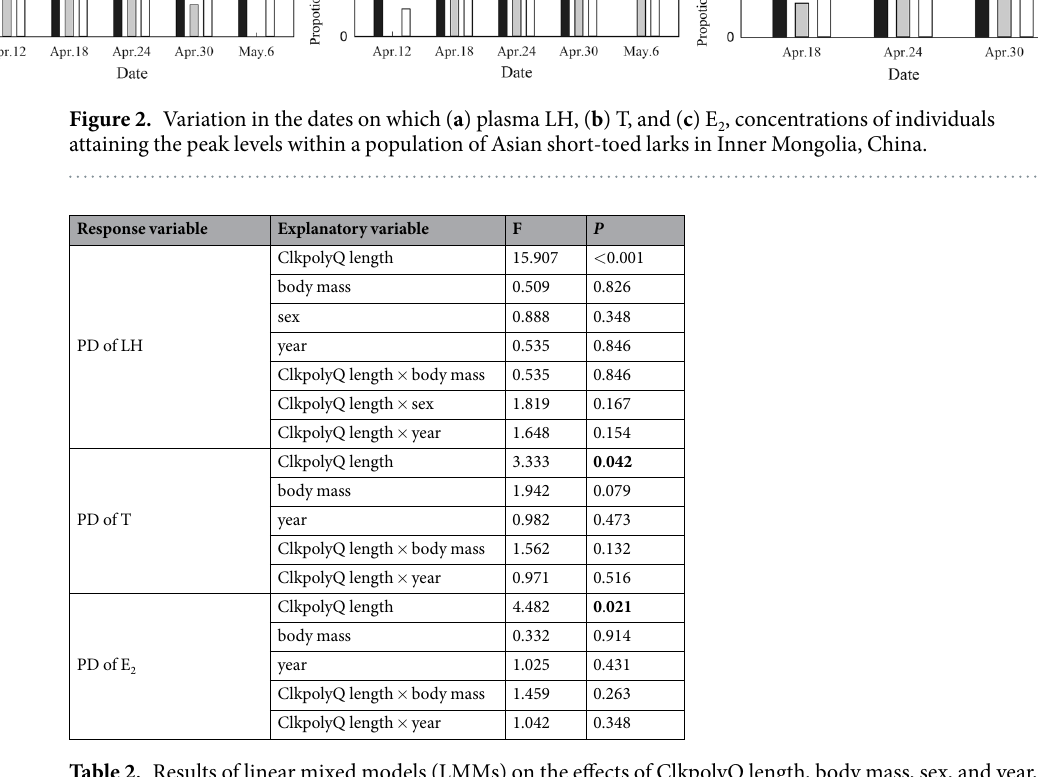
Table 2. Results of linear mixed models (LMMs) on the effects of ClkpolyQ length, body mass, sex, and year, on peak date deviation (PD) of plasma luteinizing hormone (LH), and on the PDs of plasma testosterone (T) and estradiol (E 2 ), of wild-caught, captive, Asian short-toed larks in Inner Mongolia,